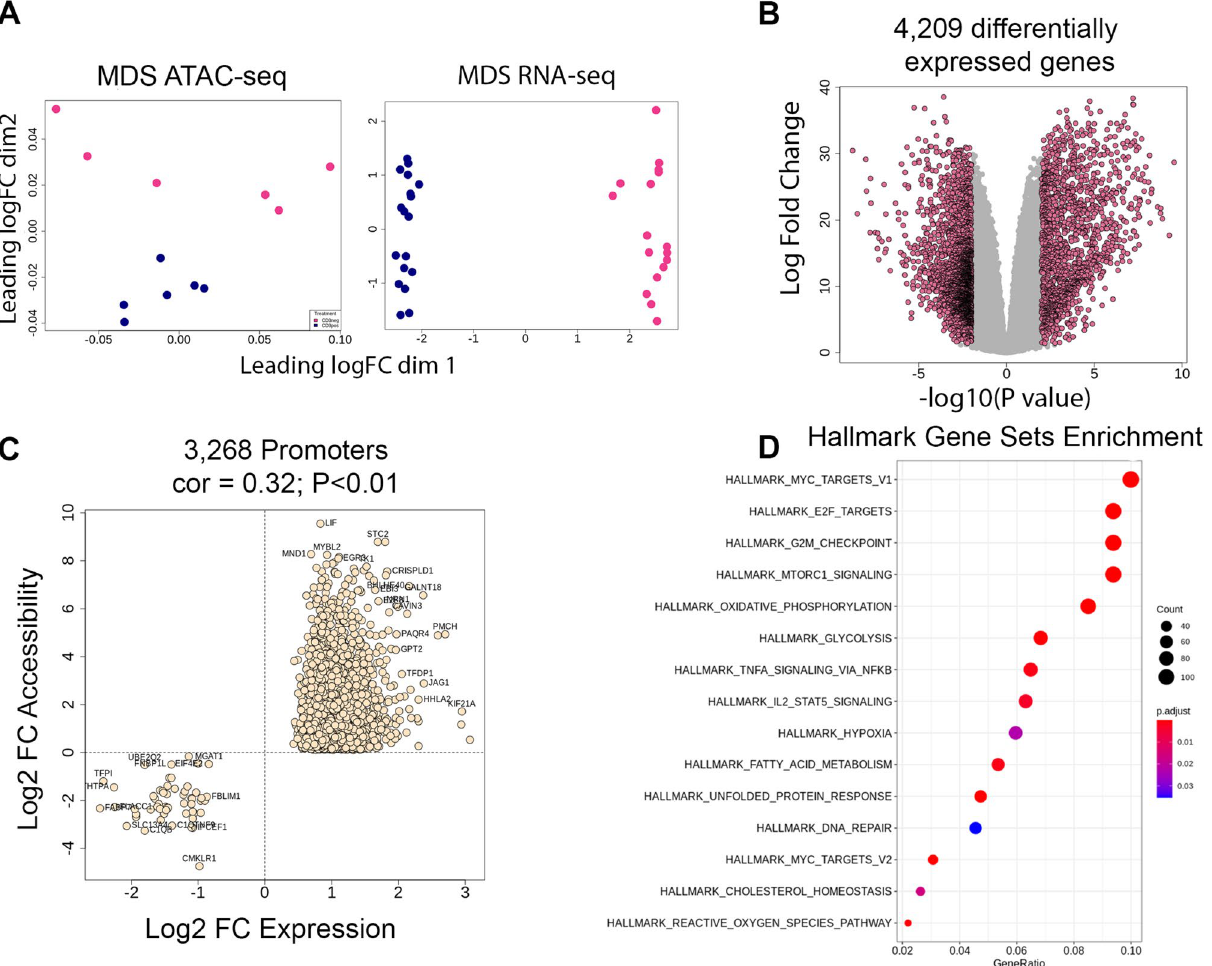
Figure 3. Analysis of gene expression at stimulus-dependent accessible regions. (A) Multidimensional scaling analysis of accessibility (all detected peaks) and expressed genes (all unique transcripts). (B) Volcanoplot of differentially expressed genes (FDR < 0.05 & log2FC + /− 2; pink dots). (C) Scatterplot of accessibility log fold changes and gene expression fold changes (act—quiescent) for FDR-significant hits annotated to promoter regions. Cor Pearson’s correlation coefficient. (D) Dotplot of enriched Hallmark gene sets among 3268 promoter